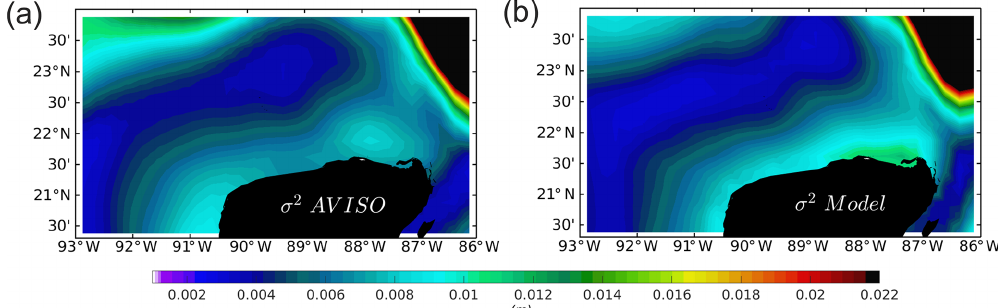
Figure A7. Variance ( σ 2 , m) for the range of the years 2002–2010 of (a) absolute dynamic topography (ADT) extracted from the AVISO altimeter product and (b) mean sea level ( η ) from the ROMS